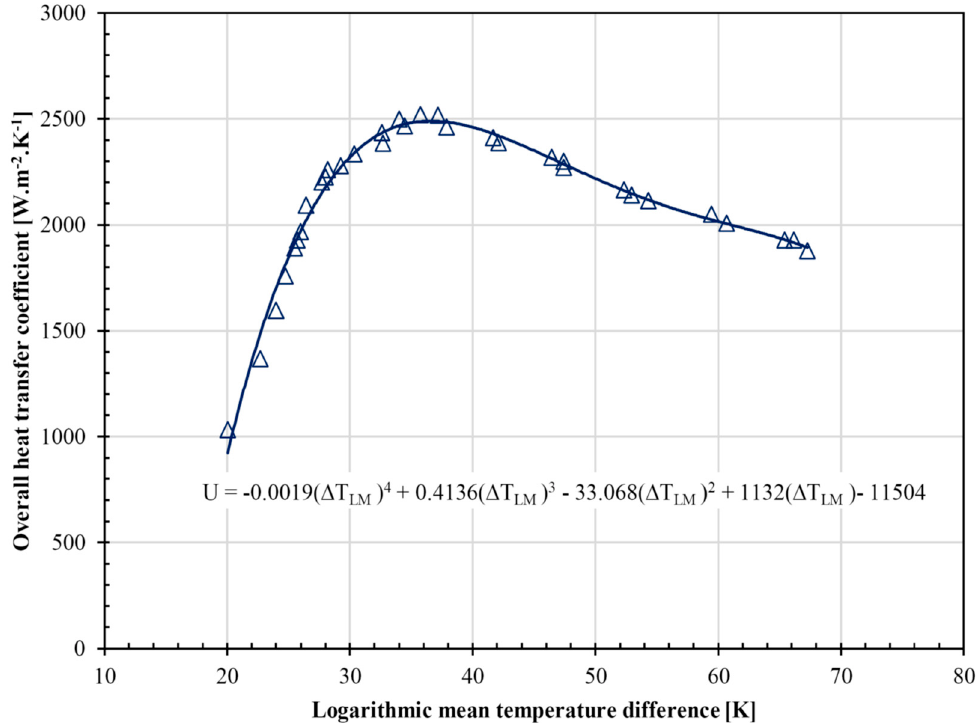
ffi cient in the case of a vertical Figure 10. Overall heat transfer coefficient in the case of a vertical microchannel. Figure 10. Overall heat transfer coe